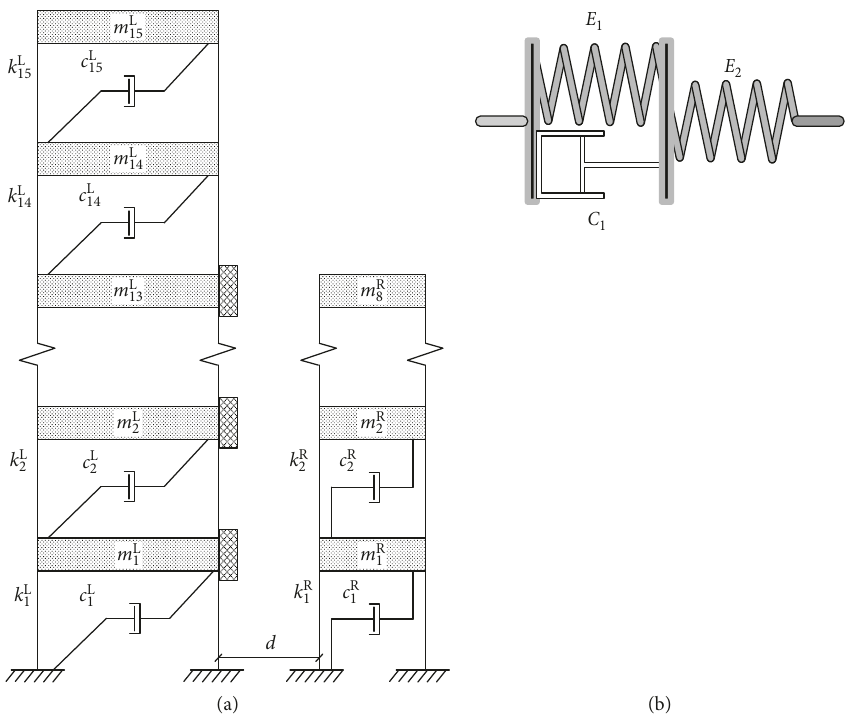
Figure 1: Model of colliding frames and viscoelastic models: (a) two concrete frame buildings (left: a fifteen-storey building; right: an eight- storey building); (b) viscoelastic models (3-parameters solid). Table 1: Properties of buildings. Structural characteristics Left building Right